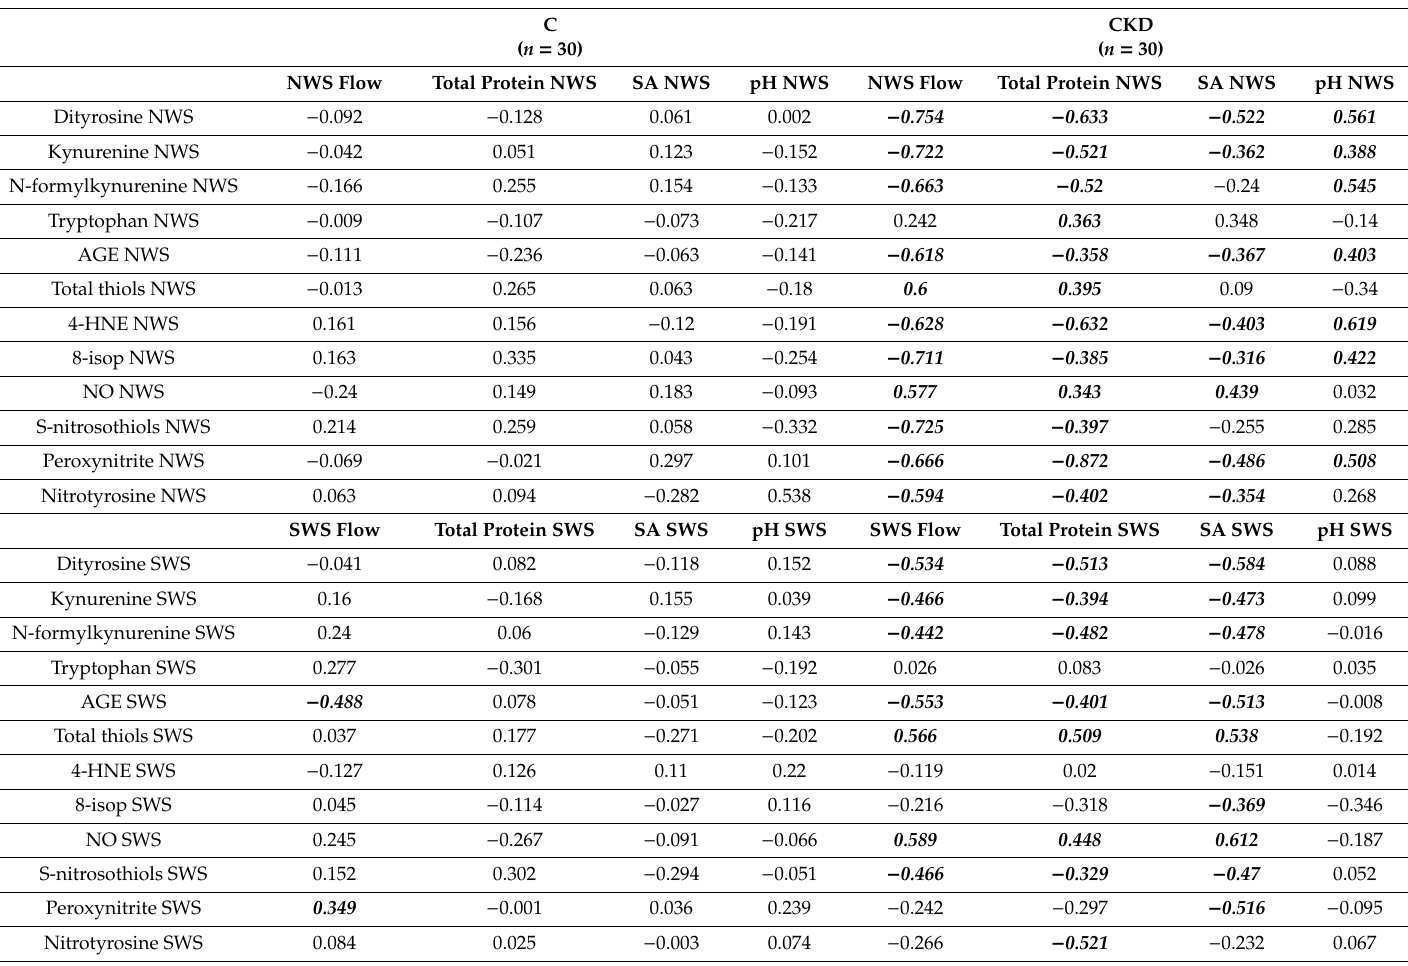
Table 4. Correlations between analyzed redox biomarkers and salivary gland function and salivary pH of children with chronic kidney disease (CKD) and healthy